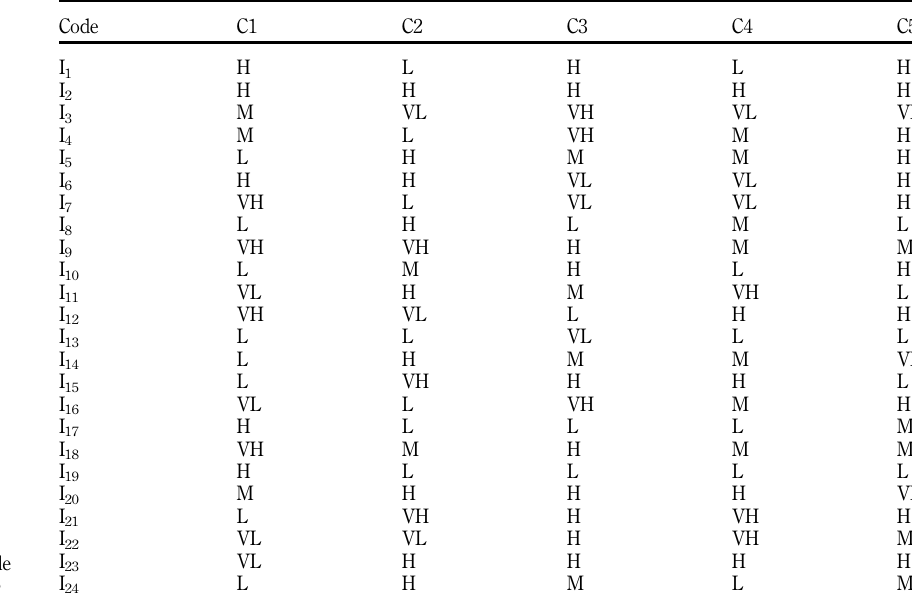
Table A6. Linguistic variable assigned by DM6